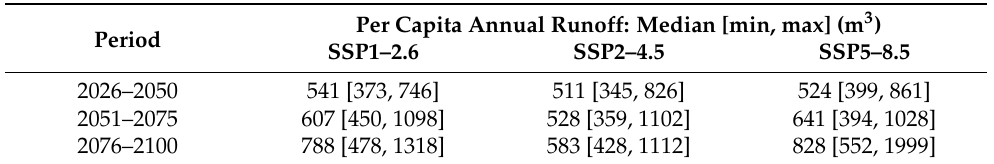
Table 4. Projected annual runoff per capita for the near-, mid-, and long-term periods under the SSP1–2.6, SSP2–4.5, and SSP5–8.5 scenarios.